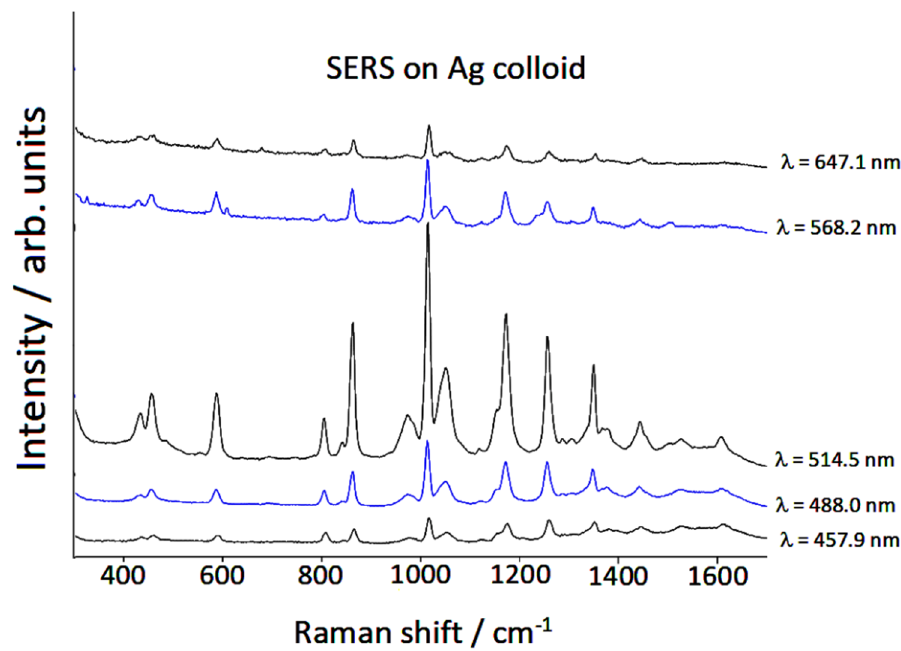
Figure 5. SERS spectra of piperidine by excitation with different laser lines.